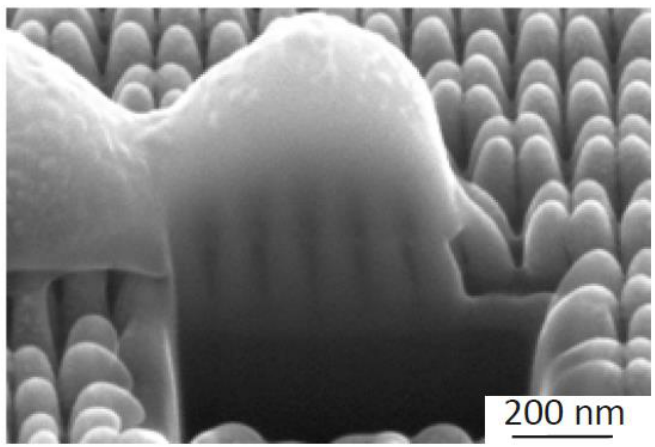
Figure 5. The SEM image of the interface between bacteria and the 100 O nanopattern. The depth of direct penetration of the nanopillars into the bacterial cell wall (about 100 nm) far exceeds the average cell wall thickness of S. aureus (i.e., 10–20